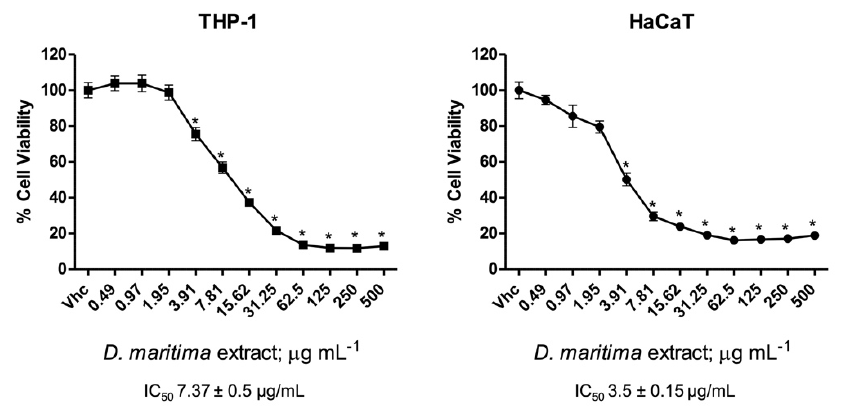
Figure 3. Drimia pancration extract cytotoxic effect: cell viability was determined in THP-1 and HaCaT cell lines by MTT assay. Cells were treated for 72 h with different extract concentrations. Data are expressed as mean ± SD of three separate experiments. * p < 0.05 vs. vehicle (Vhc).